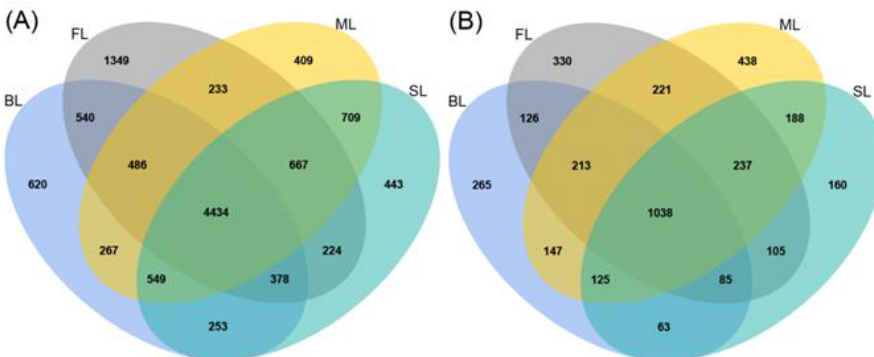
Figure 3. Venn diagrams showing the unique and shared OTUs of bacteria ( A ) and fungi ( B ) in four land-use types.